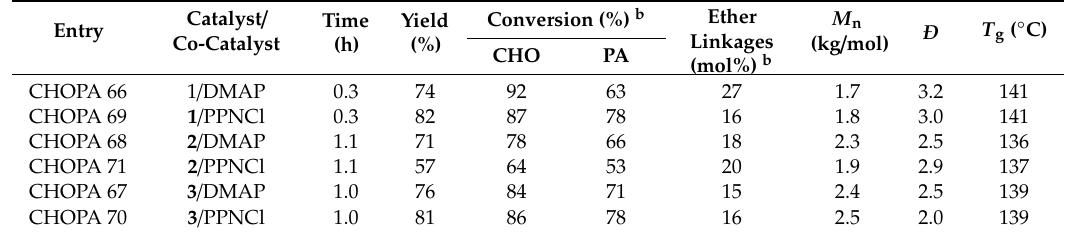
Table 1. Cyclohexene oxide (CHO) / phthalic anhydride (PA) bulk copolymerization a